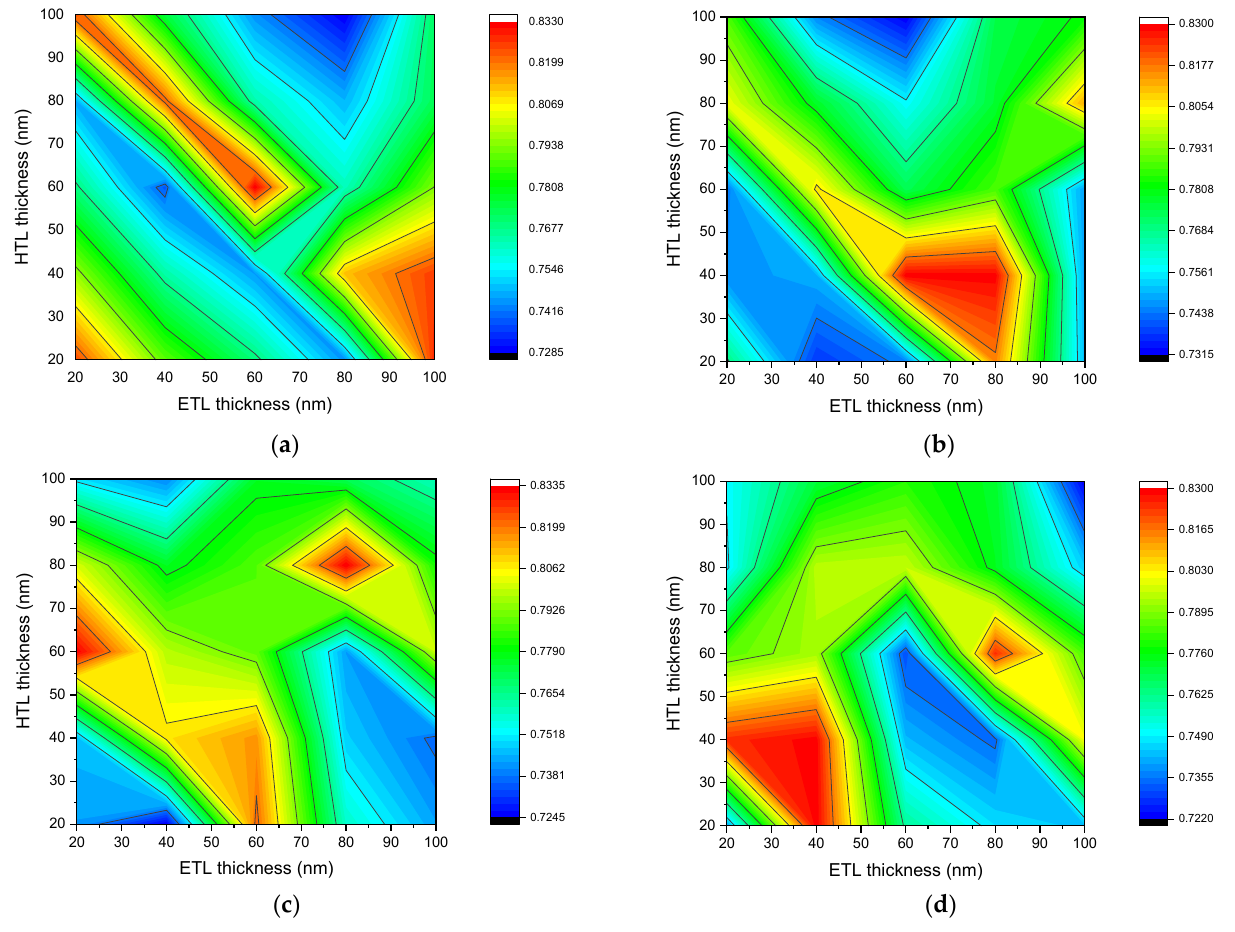
Figure 5. Dependence of fill factor of n-ZnO/p-CH 3 NH 3 PbI 3 /p-NiO x solar cell with perovskite layer thickness of 200 nm ( a ), 400 nm ( b ), 600 nm ( c ), and 800 nm ( d ) on the ETL and HTL layer thick- nesses.